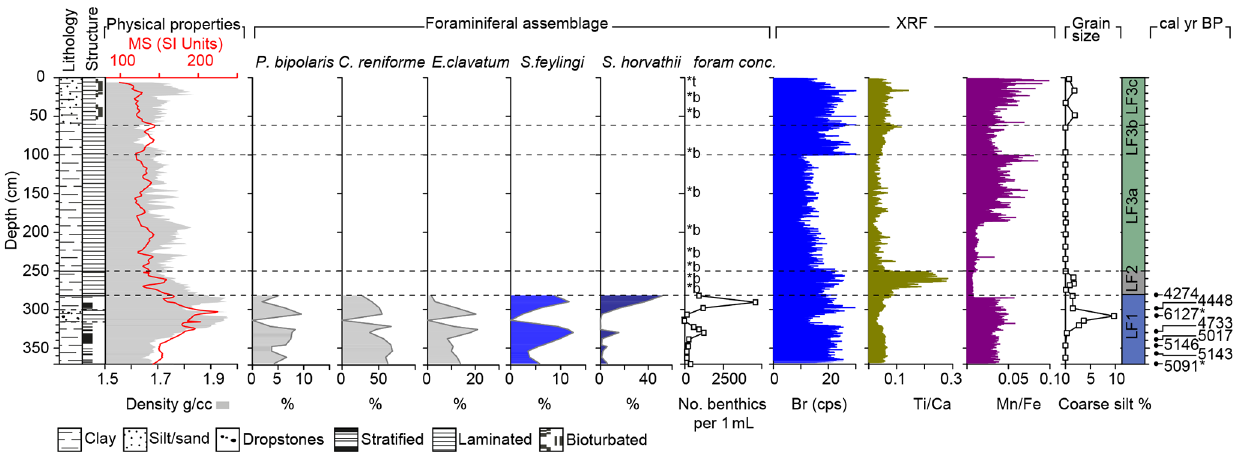
Figure 5. Multi-proxy data for core LC12, including simplified core lithology/structure, physical properties (magnetic susceptibility (MS) and density), foraminiferal assemblage data (barren (b) and trace (t; < 20) foraminifera), and selected XRF-scanner and grain-size (coarse-